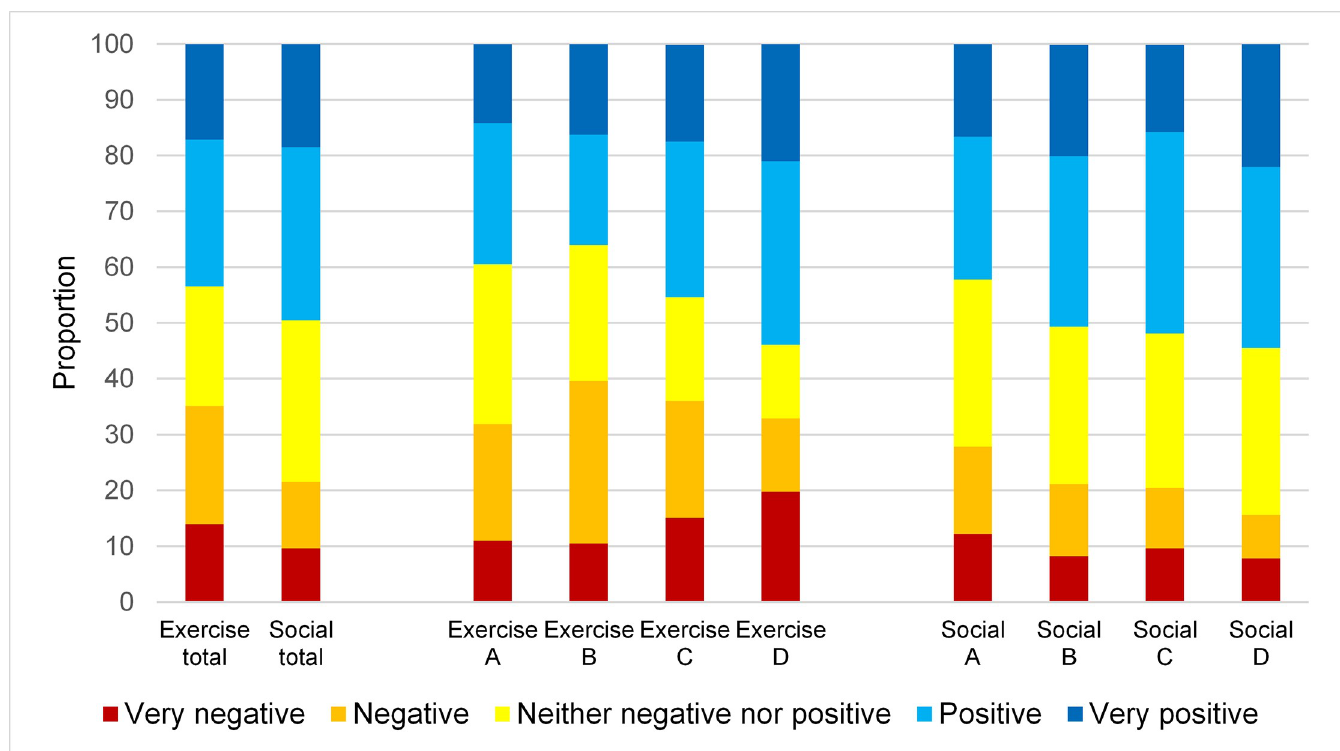
Fig 4. Motivation to go to activity sessions in exercise and social activity group, in total and in assessment periods A-D.